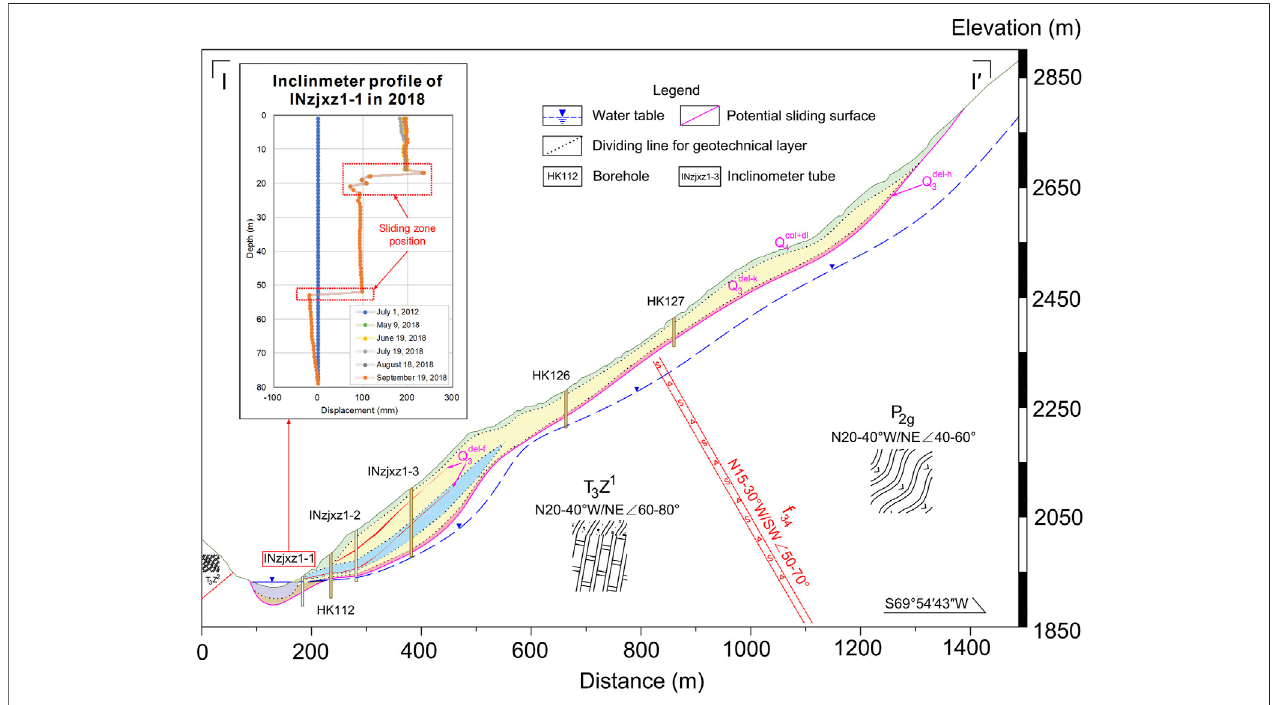
FIGURE 2 | Pro fi le I-I ′ of the Zhoujia landslide.